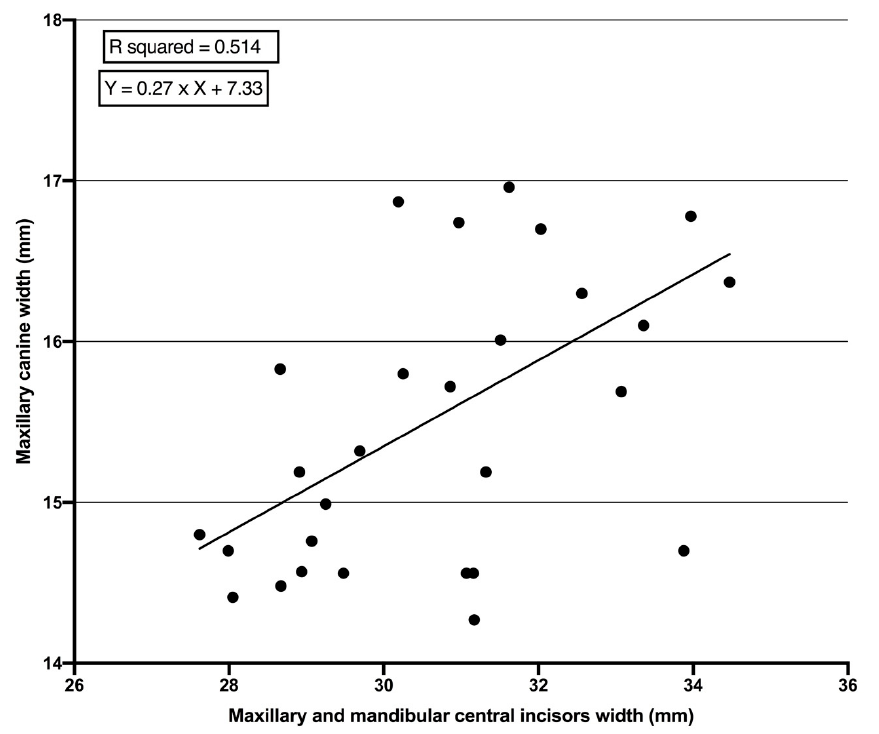
Figure 3. Linear regression line between mesio-distal widths of permanent maxillary and mandibular central incisors and mesio-distal widths of permanent maxillary canines in females.